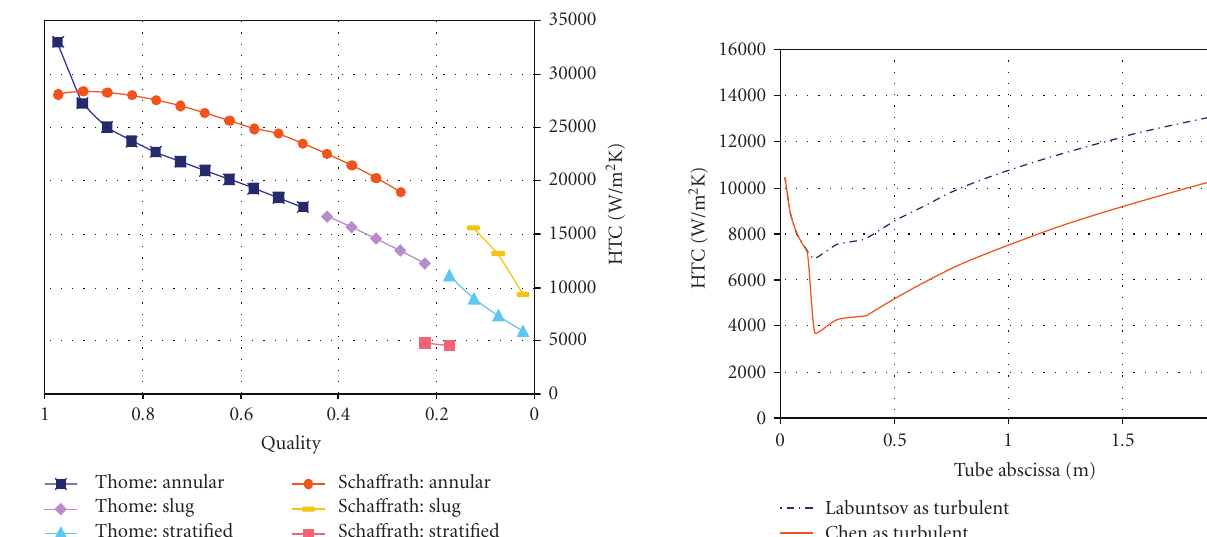
Figure 16: Comparison between Thome’s analysis and Scha ff rath’s analysis at very high flowrates (G = 984.8 kg/sm 2 ).